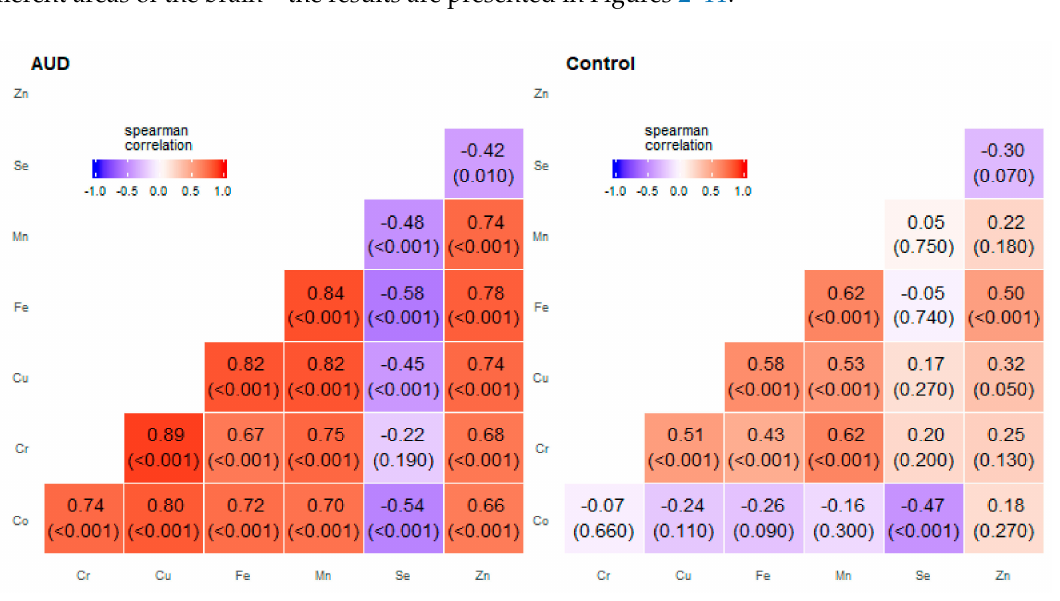
Figure 1. Correlation matrix of average brain trace element concentrations in the alcohol use disorder group and control group. The strongest relationships between average concentrations of trace elements are marked in circles. Table 1. Intervals for correlations in selected pairs of elements in the two studied groups. Pair of Trace